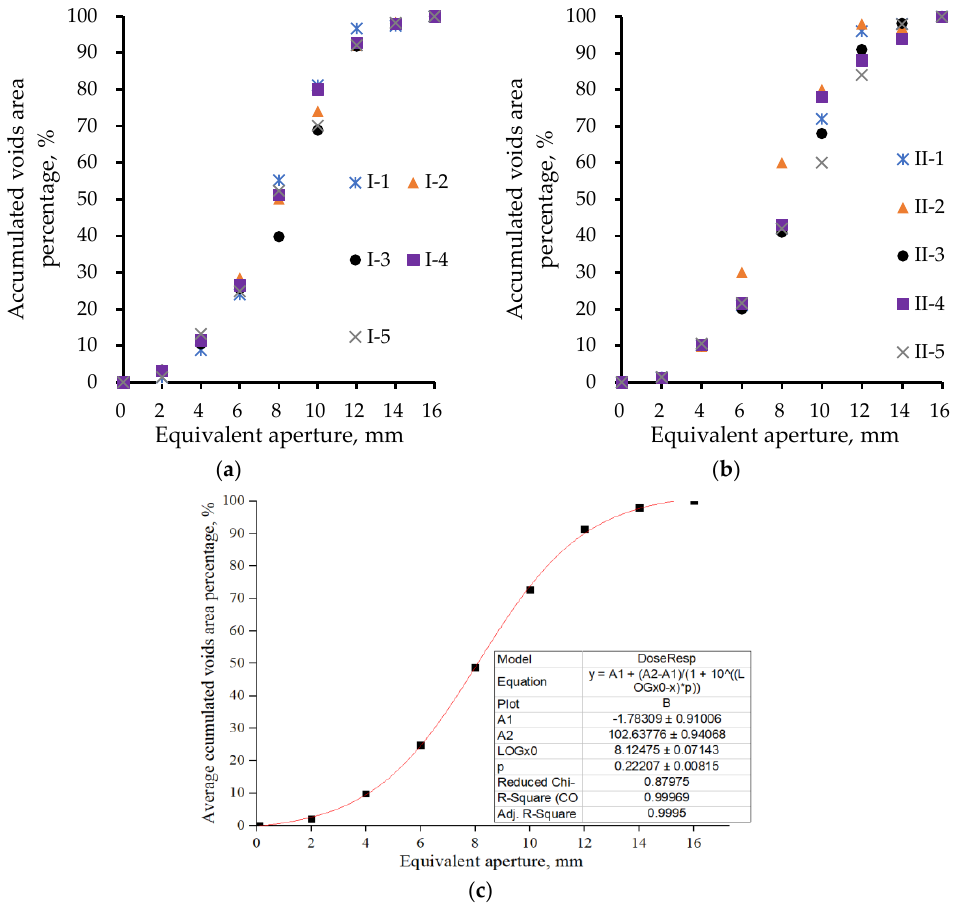
Figure 9. Relationship between accumulated voids area and the equivalent aperture, ( a ) OGFC sample I, ( b ) OGFC sample II, ( c ) Average value of OGFC samples.